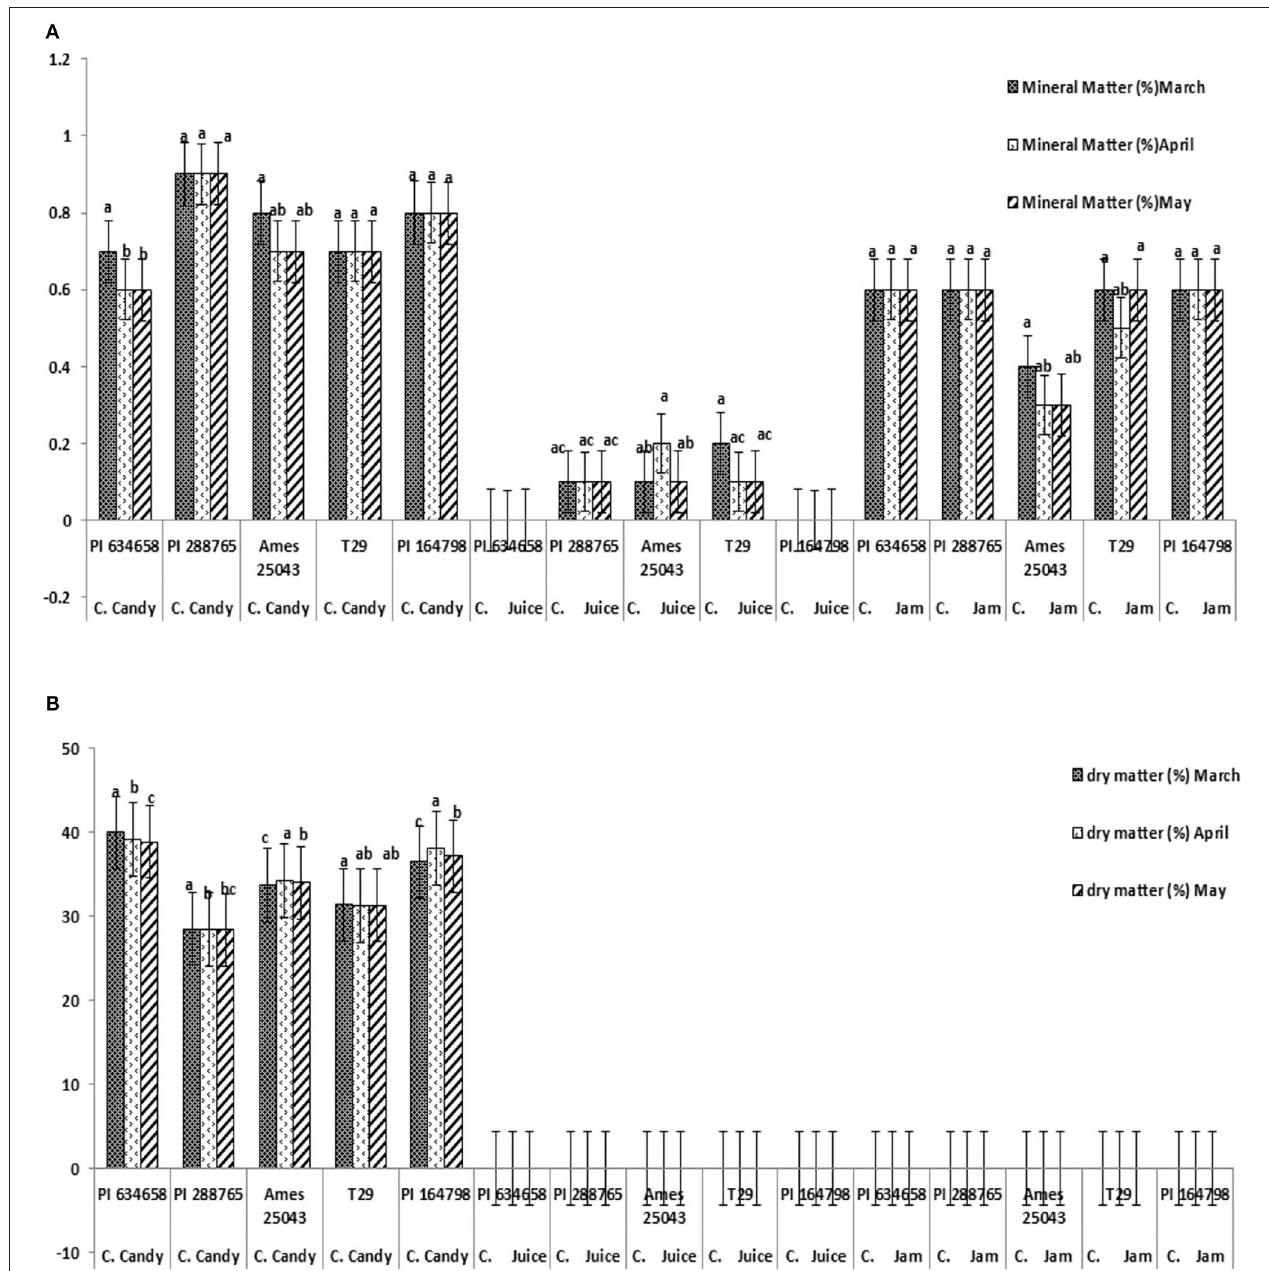
FIGURE 7 | (A) Mineral content (%) of three nutraceutical products from five carrot genotypes stored 3 months. (B) Dry matter content (%) of three products from five carrot genotypes stored 3 months.